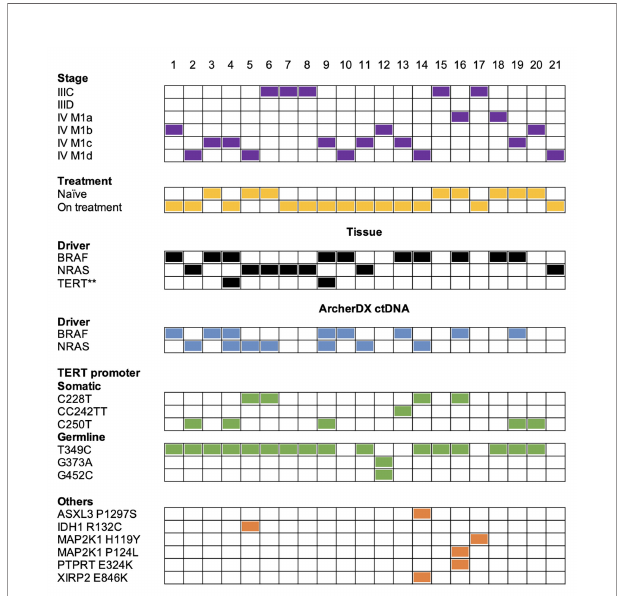
FIGURE 2 | Summary of the melanoma mutation pro fi le identi fi ed across the 21 melanoma patient samples from a cohort of 19 melanoma patients. Comparison of melanoma stage (purple boxes), treatment (yellow boxes), tissue driver mutations (black boxes) versus mutations detected with the ArcherDX custom melanoma ctDNA panel including driver mutations (blue boxes), TERT promoter somatic mutations or germline variations (green boxes) and other cancer-associated mutations (orange boxes). Numbers represent sample number. For further details on speci fi c gene variations identi fi ed and patient details refer to Table S2 . Samples 4 and 9 are derived from a single patient at two time points. Samples 7 and 8 are derived from a single patient at two time points. **Mutation data from a cell line derived from patient tissue collected 12 months after liquid biopsy